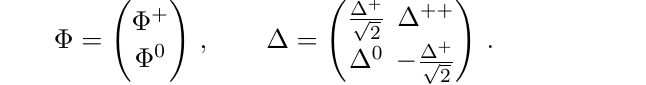
Figure 1. Characteristic Feynman diagrams for the decay (cid:28) Seesaw Model, (b) the LRSM and (c) the